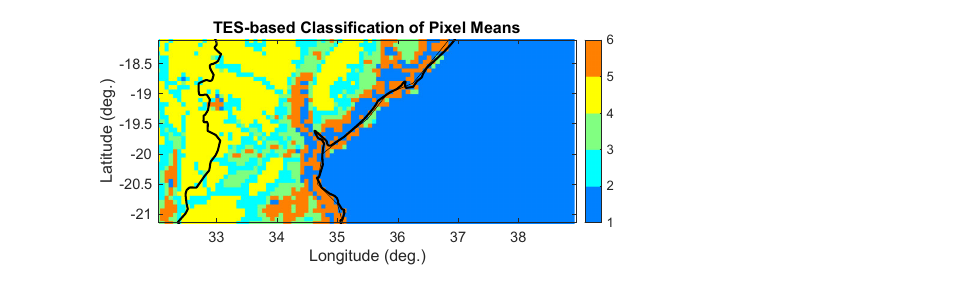
Figure 2. K-means clustering [51] classification obtained for each pixel after analyzing 1-year of data for TES values over Mozambique in 2019.